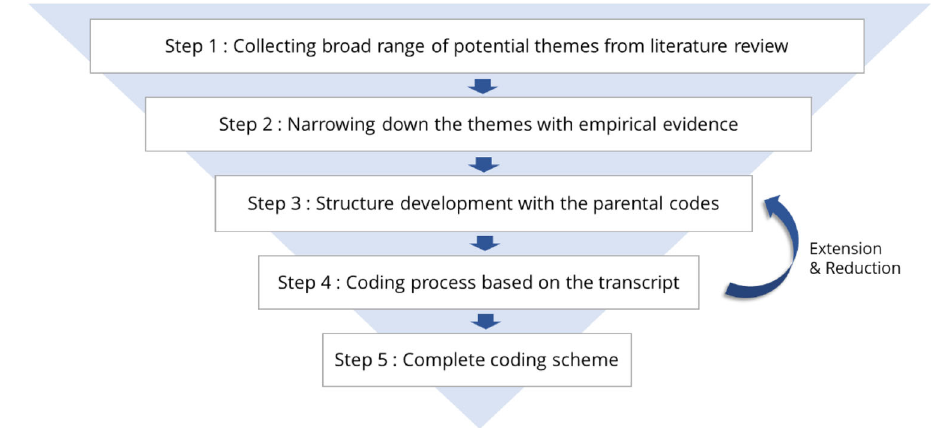
coding scheme used for thematic analysis of data derived from nature-based solutions interviews